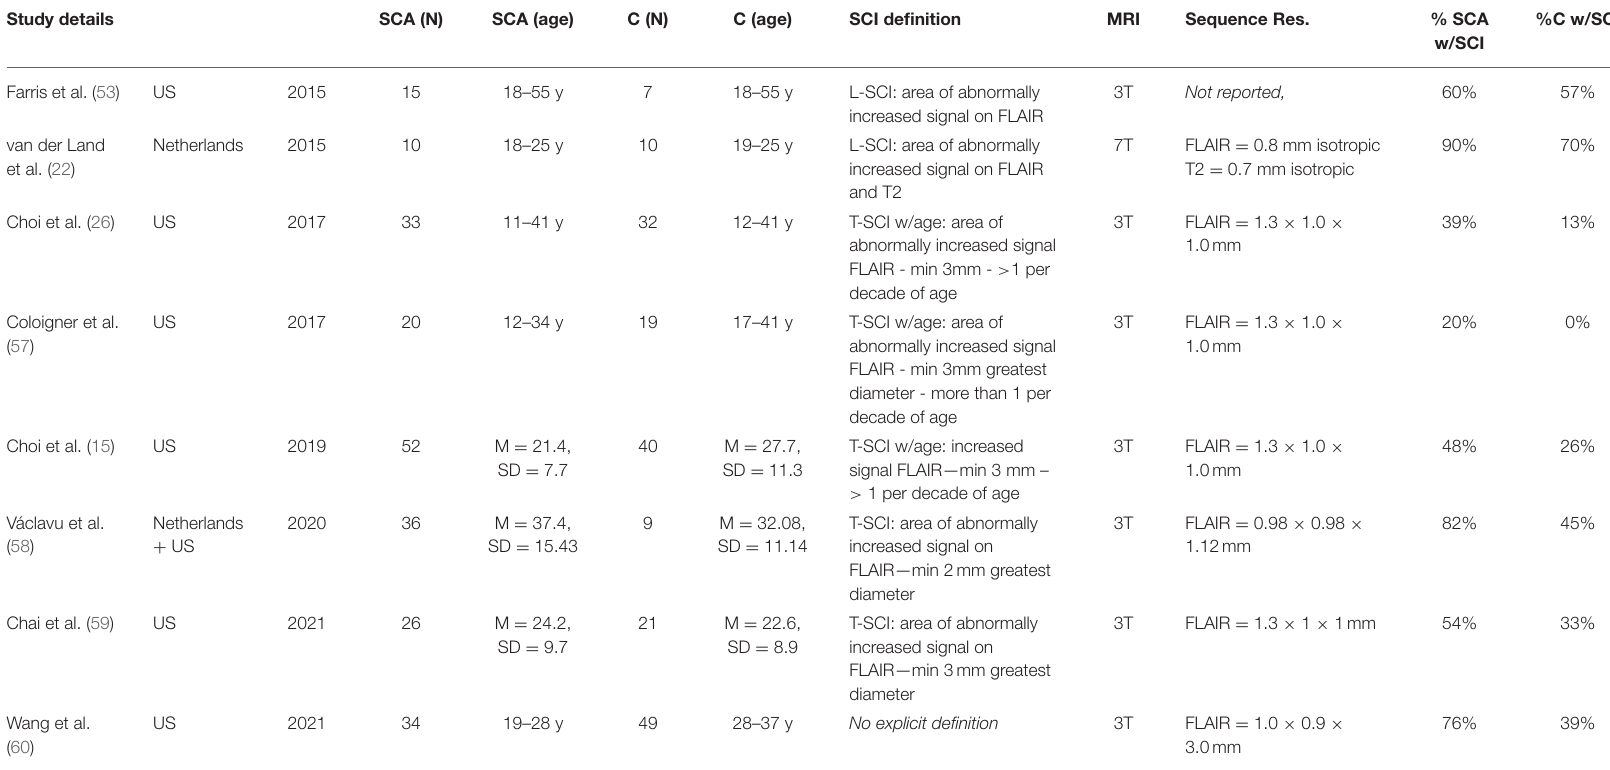
TABLE 6 | Overview of SCI prevalence in prior high-resolution imaging studies in patients with SCA and